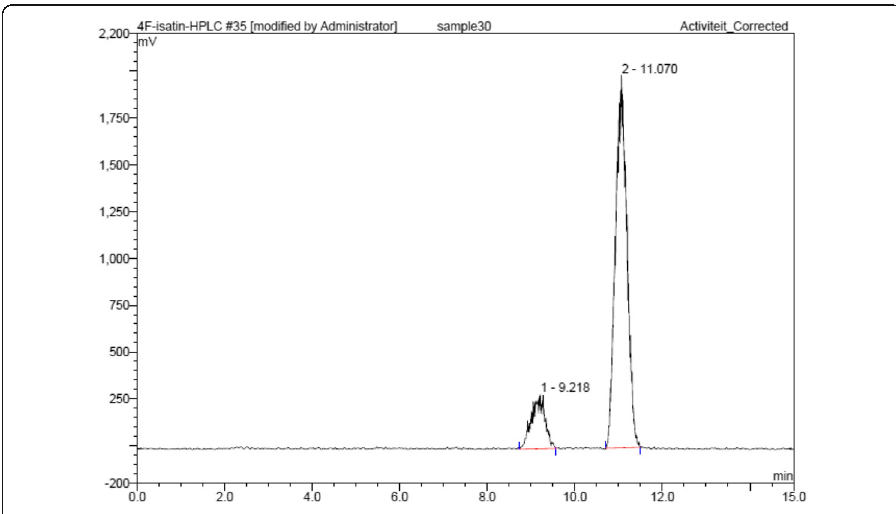
Fig. 4 A representative HPLC chromatogram (method C) of the non-polar fraction of the brain homogenate at 10 min after injection, showing both [ 18 F] 5 (Rt 11 min) and a labelled metabolite (Rt 9